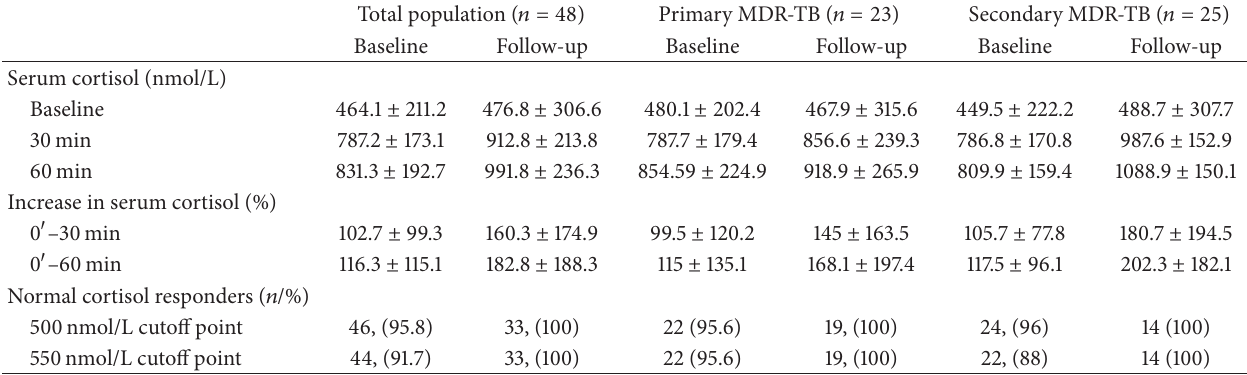
Table 2: Serum cortisol responses to the low-dose ACTH stimulation test at baseline and